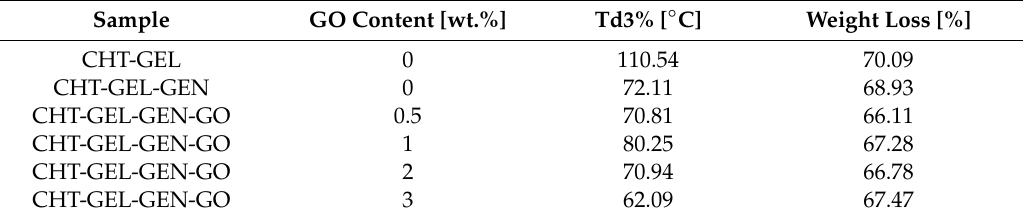
Table 1. TGA numerical data of Td3% and final weight